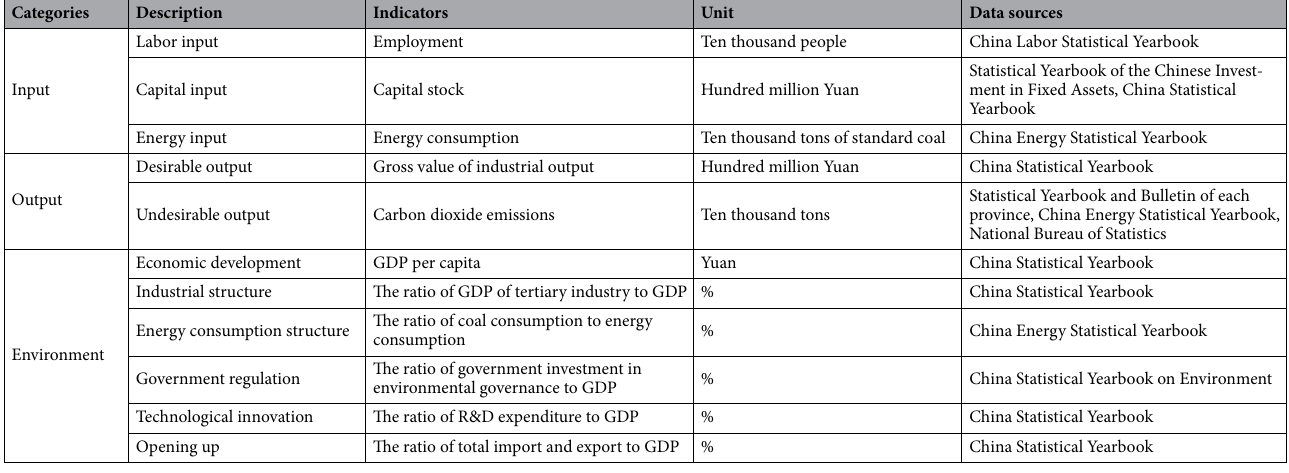
Table 2. Indicators for measuring